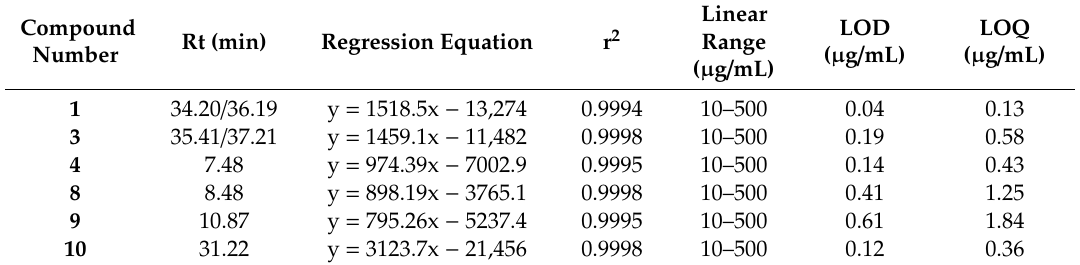
Table 6. Linear relation between peak area and concentration ( n =